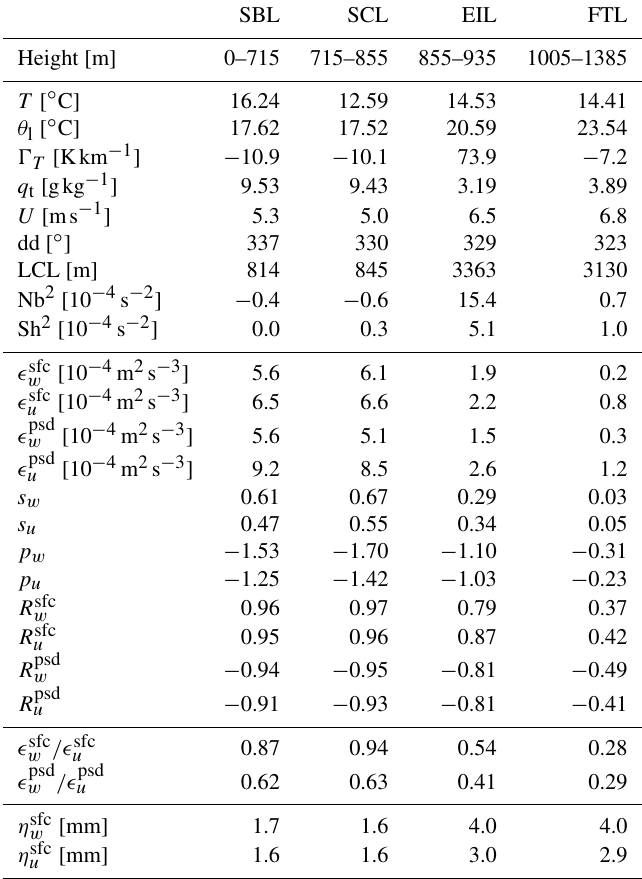
Table A1. Average conditions inside the sublayers in the case of coupled STBL (flight no.